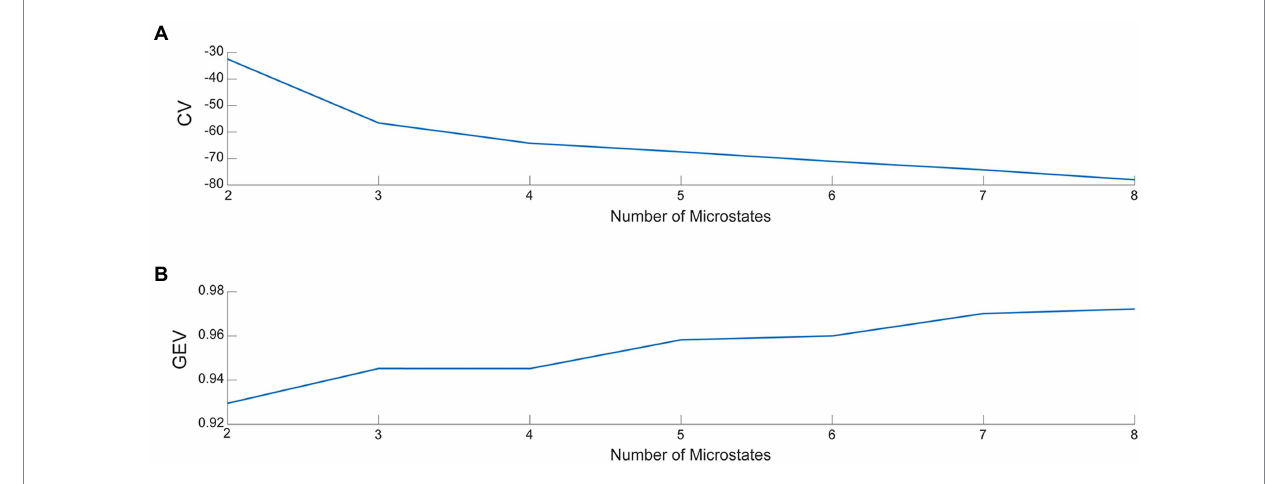
FIGURE 3 (A) The value of CV for various microstate classifications. (B) The value of GEV for various microstate